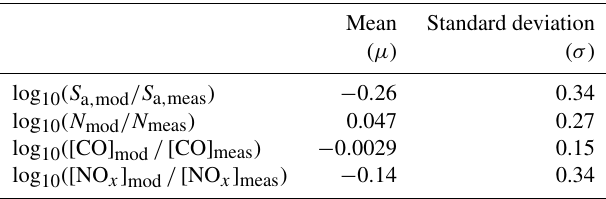
Table 3. Probability density function (PDF) fit parameters for the distributions shown in Fig.